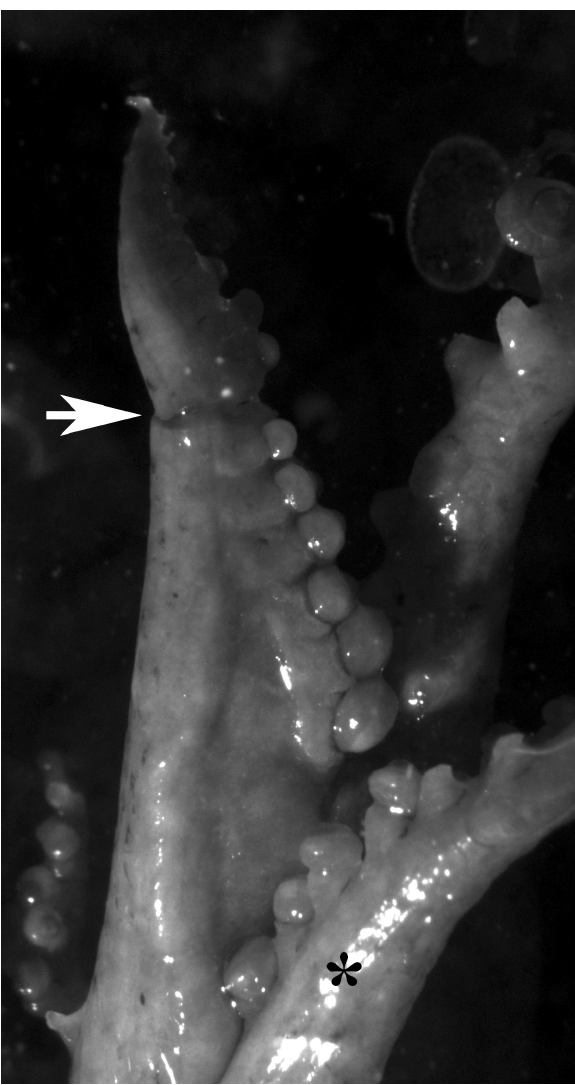
Fig. 10. – Inner lateral view of the hectocotylus of Sepiola bursad- haesa n. sp., paratype, MNCN 15.06/226P8, male. The arrow points to the semi-circular groove perpendicular to the arm axis separating the distalmost part of the hectocotylus from its proximal part, at the level of the lateral groove distal end. The six-sucker crest bordering the lateral groove is clearly visible. Note also how some proximal suckers of the dorsal row of right arm I (marked with an asterisk) fit into the hectocotylus lateral groove.